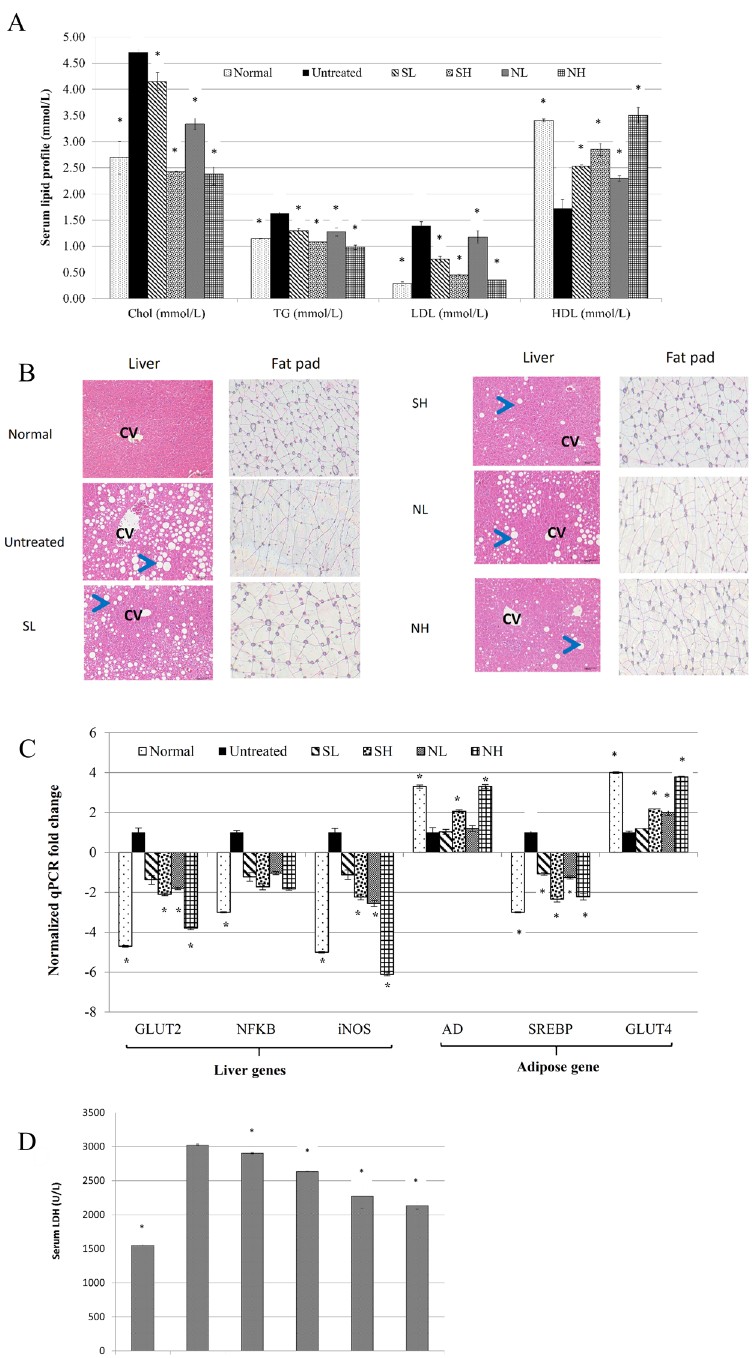
Figure 2. ( A ) Serum lipid profile (total cholesterol, total TG, LDL and HDL). ( B ) Representative histopathological analyses of the liver and fat pad (CV represents the central vain; the arrow indicates a lipid droplet; magnification: 100x). ( C ) qPCR analyses of liver inflammation and obesity-related gene expression. ( D ) Serum LDH levels of normal healthy, untreated, and 0.08-ml/kg BW synthetic acetic acid vinegar (SL), 2-ml/ kg BW synthetic acetic acid vinegar (SH), 0.08-ml/kg BW Nipa vinegar (NL) and 2-ml/kg BW Nipa vinegar NH-treated obese mice at week 33. The data are presented as averages of biological replicates (n = 6) from the same treatment group. Significant values were calculated relative to the untreated group ( * p < 0.05). Values marked with * differed significantly compared to untreated groups (p <